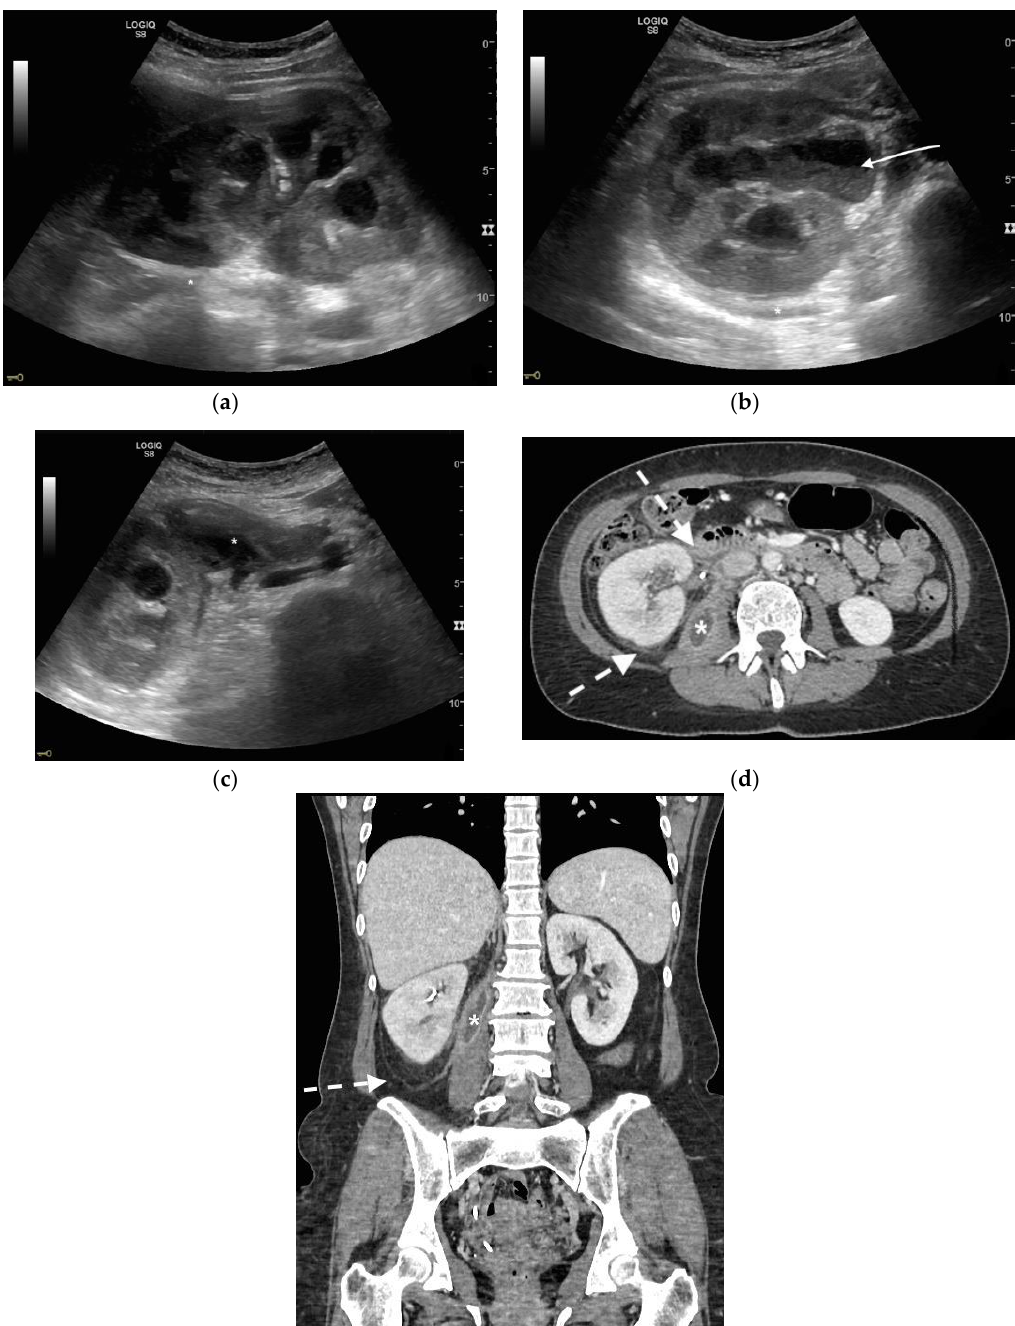
Figure 5. A 48 years old septic woman. US longitudinal ( a ) and axial ( b , c ) view of the right kidney. Enlargement of the kidney, hydronephrosis with sharply defined urine-debris level (white arrow). Thickening of perirenal fascia and markedly inhomogeneous echogenicity of perirenal fat suggesting extrarenal extension (*). The patient underwent nephrostomy in the emergency setting, and CT was performed after stent placement. Axial ( d ) and MPR coronal ( e ) CT with intravenous contrast in parenchymal phase, showing correct stent positioning (white arrow) and drainage of calyceal-pelvic system. The right kidney appeared enlarged with a delayed parenchymal phase, the calyceal-pelvic system was unstretched after nephrostomy placement. Right perirenal fascia was thickened posteriorly (dashed arrow) and extrarenal extension of the pathology was confirmed by the presence of an abscess in the right iliopsoas muscle (*).